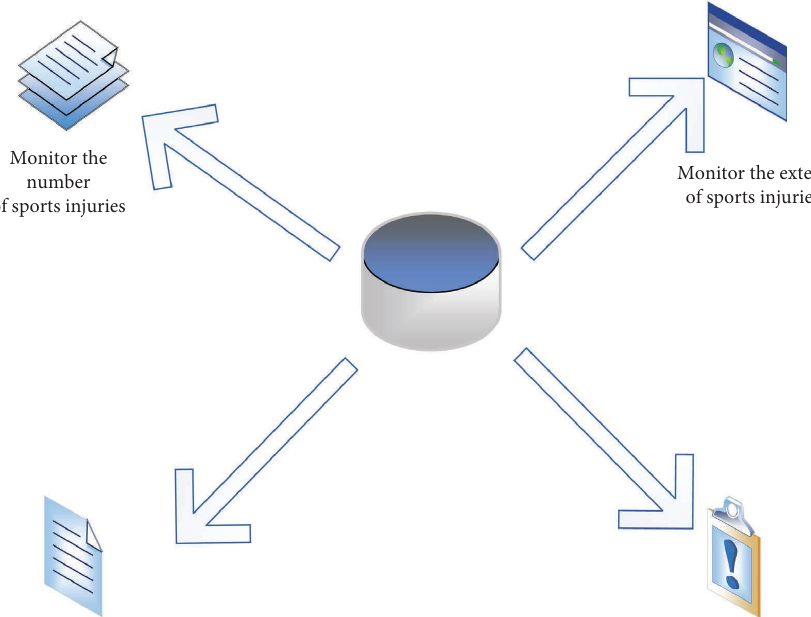
Figure 3: Functions of the automatic sports injury detection system.